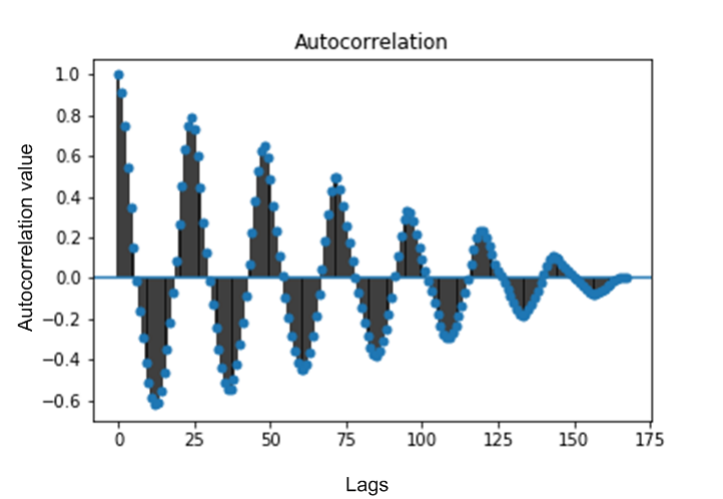
Figure 10. Temporal correlation over a week